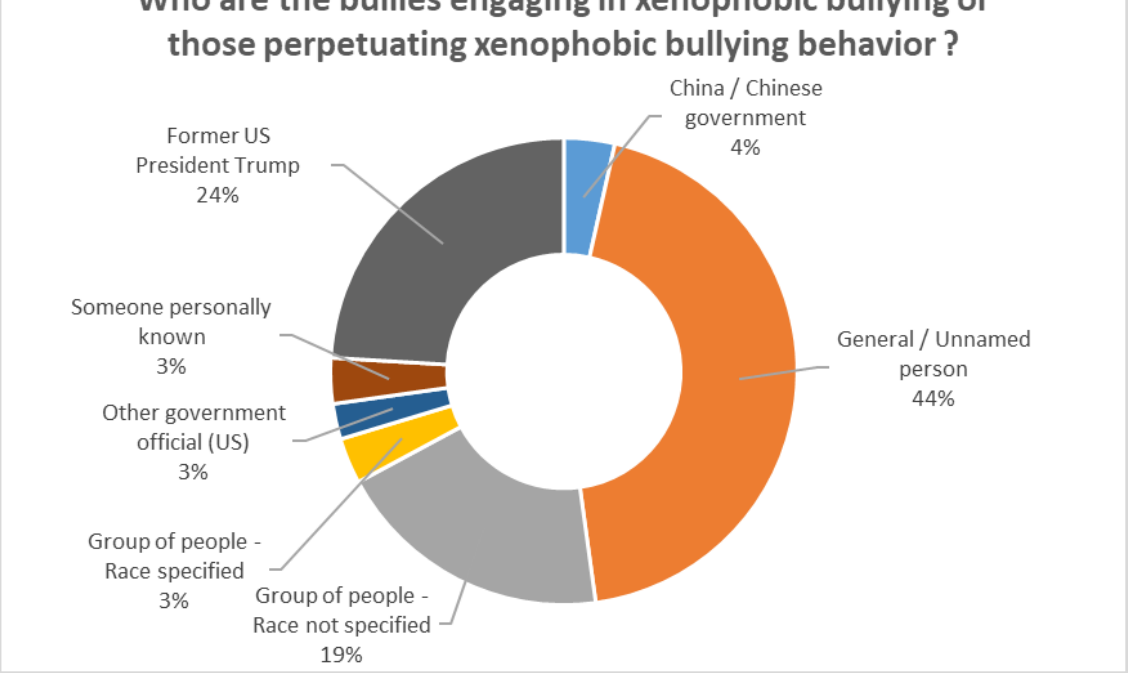
Figure 2. Xenophobic bully characteristics.